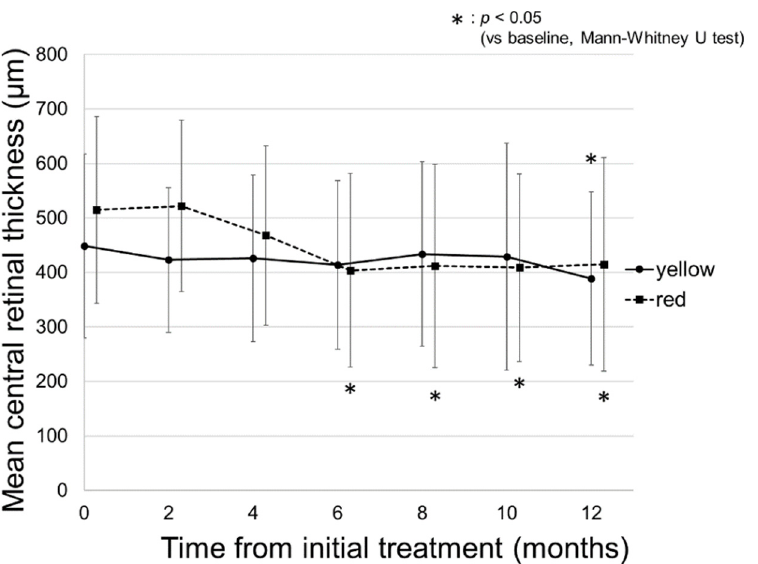
Figure 5. Changes of in the mean central retinal thickness (CRT) in the yellow and red subthreshold micropulse laser (SMPL) groups. The mean CRT in the yellow SMPL group was 449 ± 169 µm at baseline and was 423 ± 133, 426 ± 153, 414 ± 155, 434 ± 169, 429 ± 208, and 389 ± 159 µm at 2, 4, 6, 8, 10, and 12 months from baseline. In the yellow SMPL group, the mean CRT remained consistent from baseline to 10 months, and significantly reduced at 12 months ( p = 0.30, 0.23, 0.17, 0.54, 0.55, and 0.047, respectively). The mean CRT in the red SMPL group was 515 ± 171 µm at baseline and was 522 ± 157, 468 ± 165, 404 ± 178, 412 ± 187, 409 ± 172, and 415 ± 196 µm at 2, 4, 6, 8, 10, and 12 months from baseline. A significant reduction in CRT in the red SMPL group was observed at 6 months and remained consistent for 12 months from baseline ( p = 0.63, 0.11, 0.004, 0.01, 0.005, and 0.03, respectively).